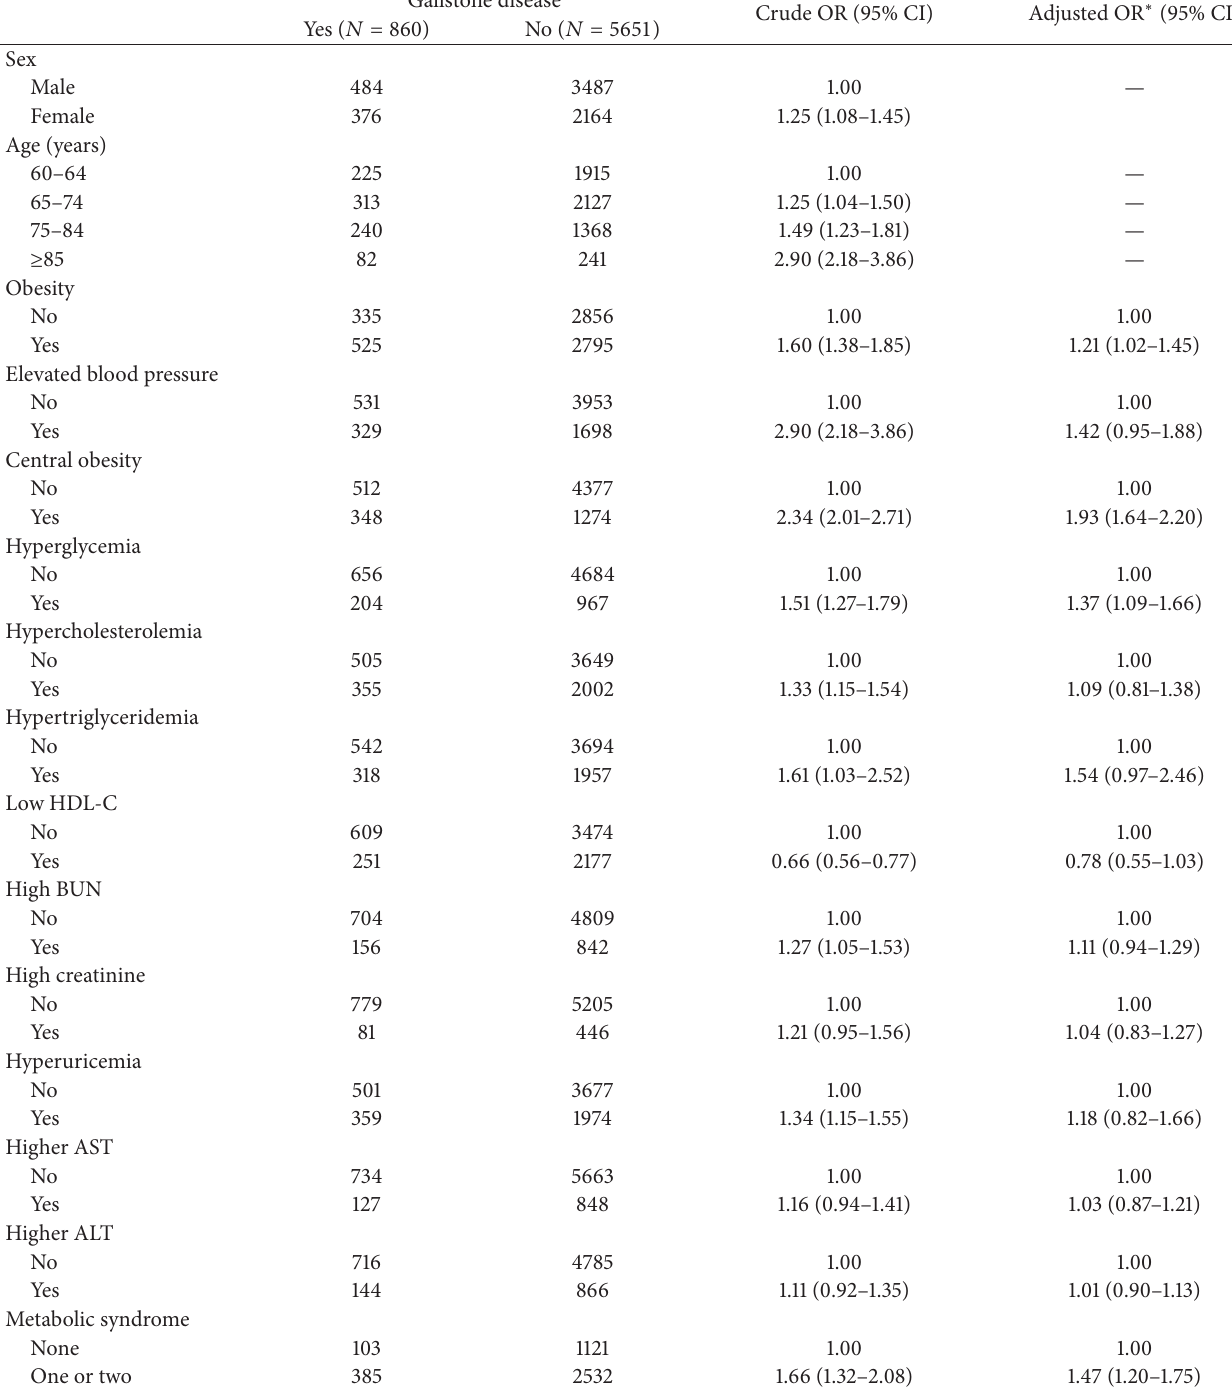
Table 2: Univariate analysis of associated clinical factors for gallstone disease among elderly agricultural and fishing screened subjects ( n =